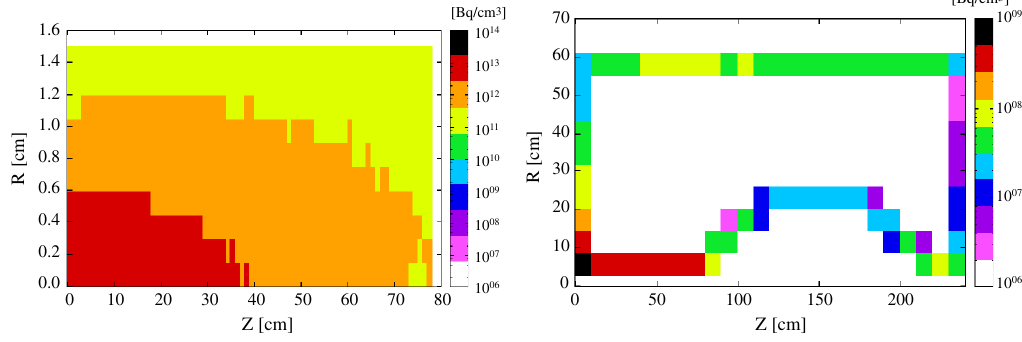
FIG. 26. Spatial distribution of the activation in the target (left) and in the horn